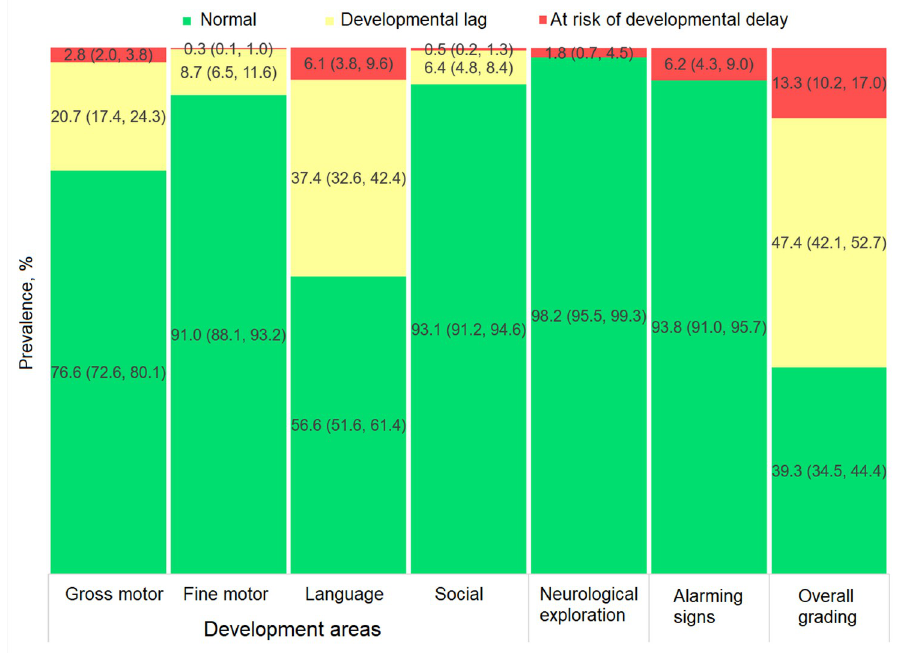
Fig 3. Prevalence of child development categories from the EDI-II test among males (n = 610).